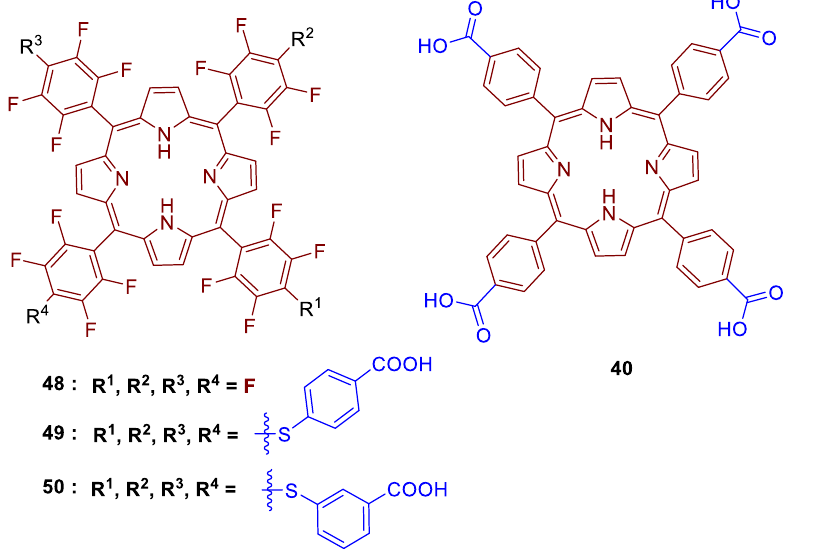
Figure 34. Porphyrinic derivatives 40 , 48 , 49 , 50 immobilized on chitosan. Adapted from Ref. [61]. Later on, the same research group functionalized 5,10,15-tris(1-methylpyridinium-4-yl)-20-(pentafluorophenyl)porphyrin tri-iodide 51 with 3- or 4-mercaptobenzoic acid, yielding two new tricationic porphyrins, 52 and 53 , with suitable carboxylic pending groups to be incorporated on chitosan (Figure 35).